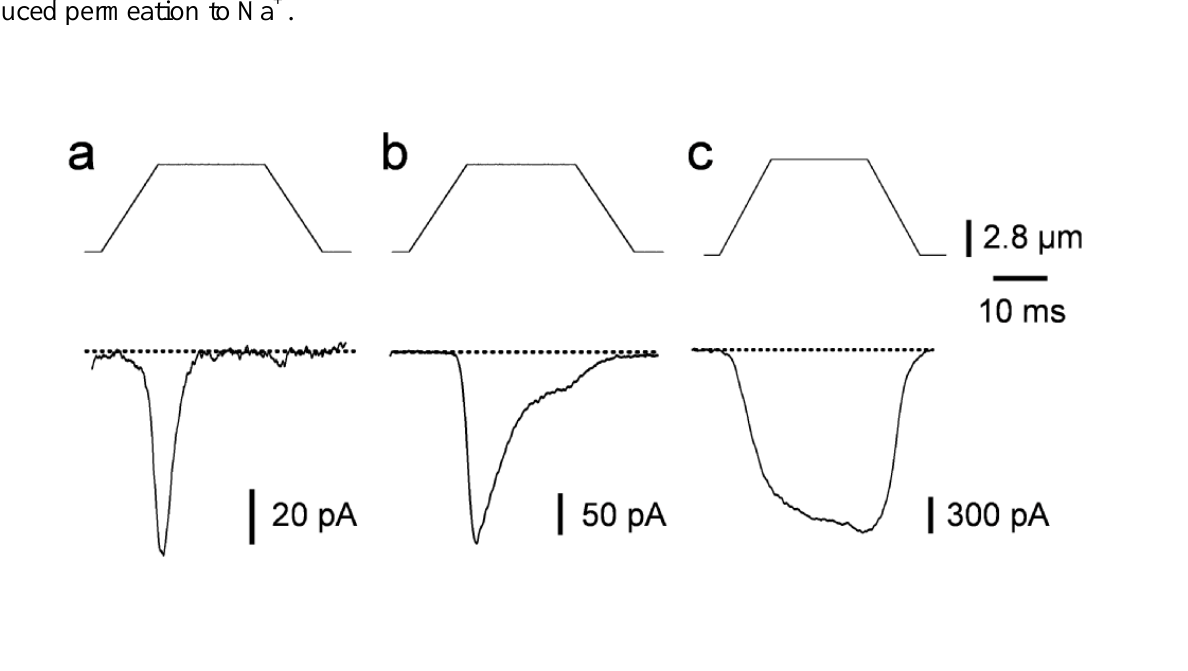
Figure 2. MS currents evoked by mechanical ramp stimuli in sensory